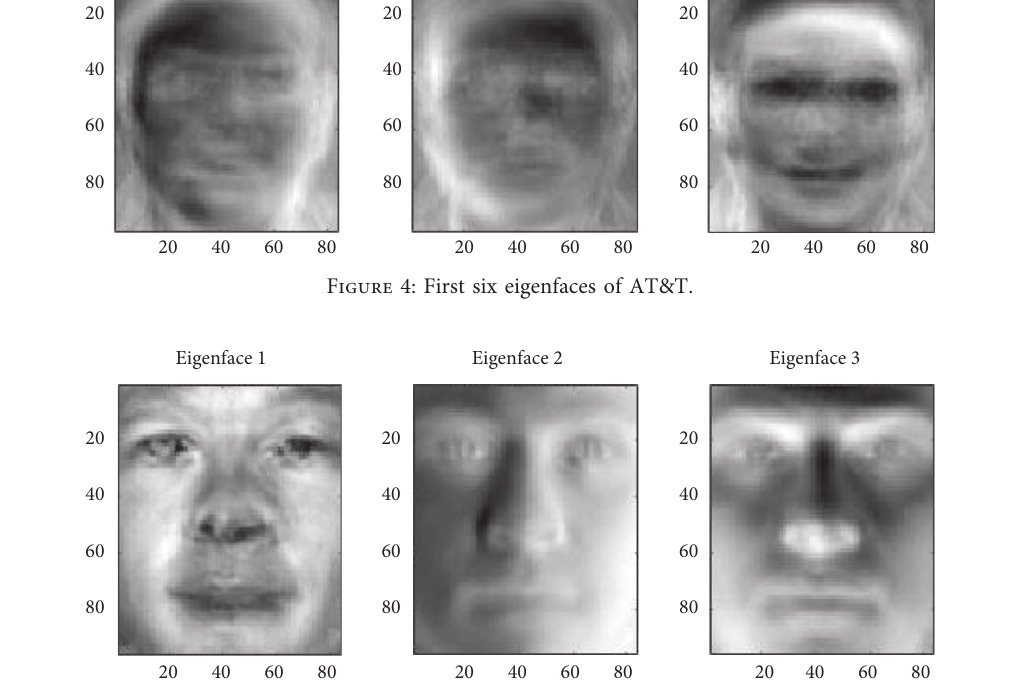
Figure 5: First three eigenfaces of YaleB. Table 1: Recognition accuracy without the use of the optimization algorithm.